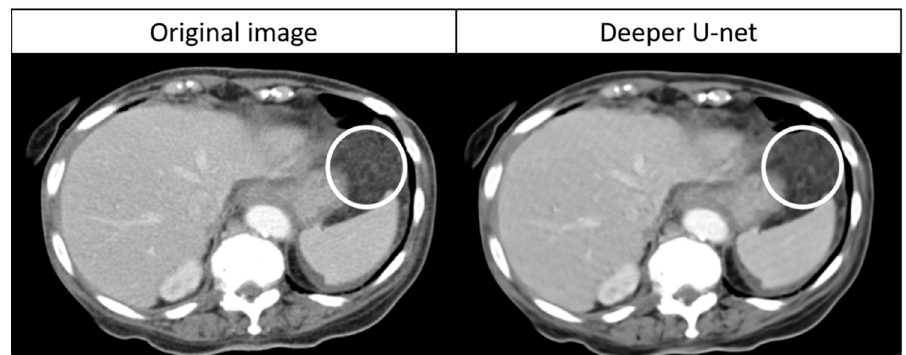
Figure 6. A representative undiagnosable lesion on denoised CT image with deeper U-net. Note: The circle shows non-measurable peritoneal dissemination. With deeper U-net, the score was 1 point for reader 1 and 2 points for reader 2.